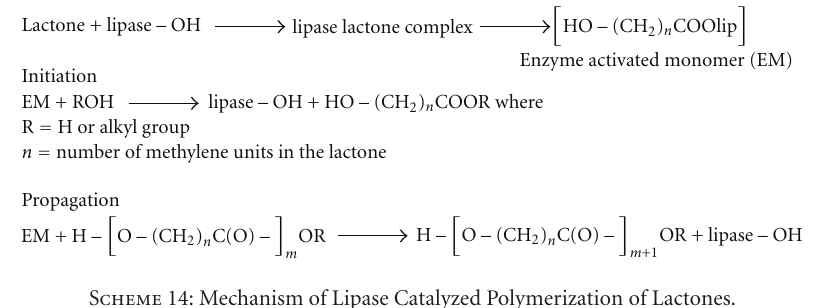
Scheme 14: Mechanism of Lipase Catalyzed Polymerization of Lactones.